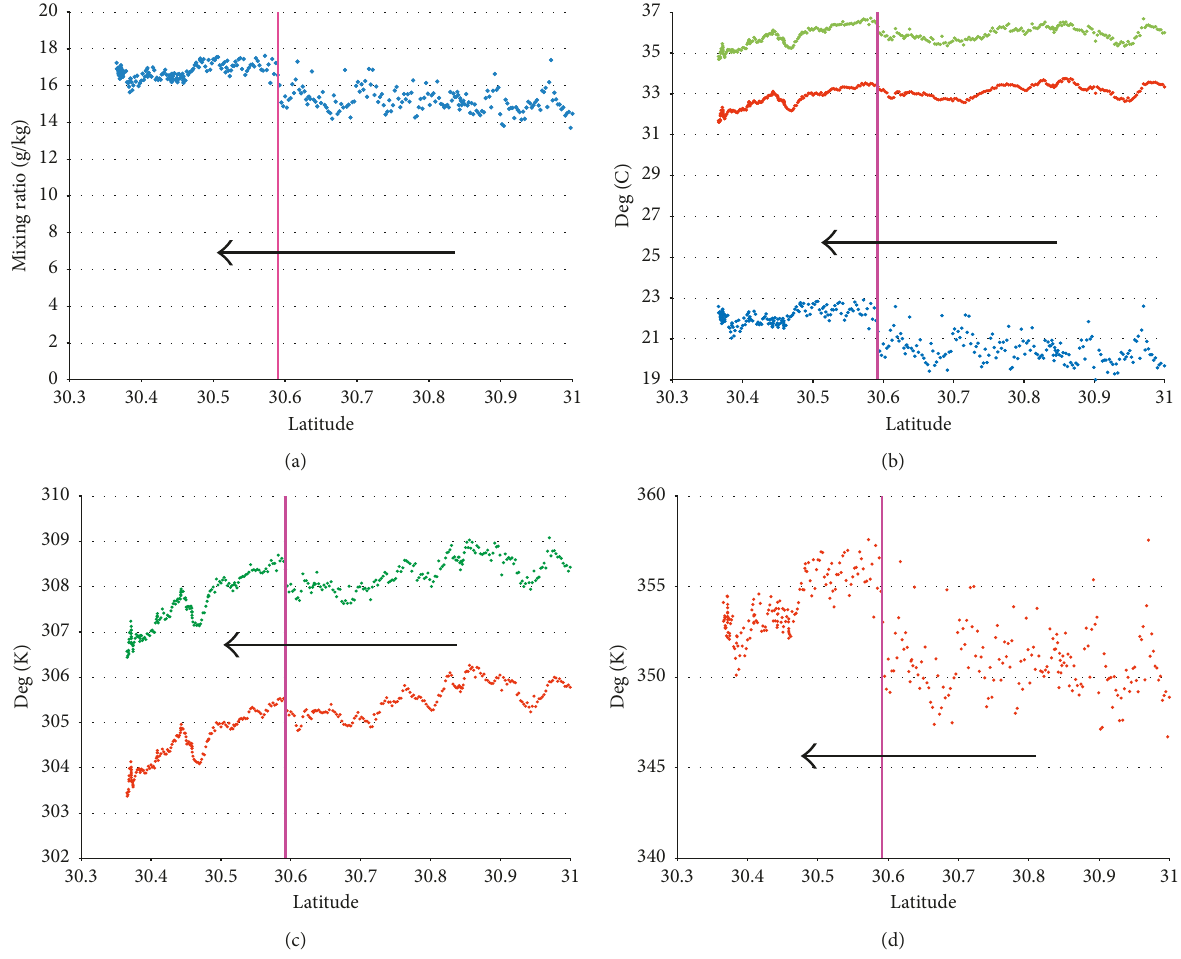
Figure 4: Southward transect data on 5 August 2014 plotted against latitude. Magenta line indicates position of SBF (as described in text). Arrows indicate the direction of vehicle motion. (a) Mixing ratio in g/kg. (b) Temperature (red), dewpoint (blue), and virtual temperature (green) (deg C). (c) Potential temperature (red) and virtual potential temperature (green) (K). (d) Equivalent potential temperature (K).